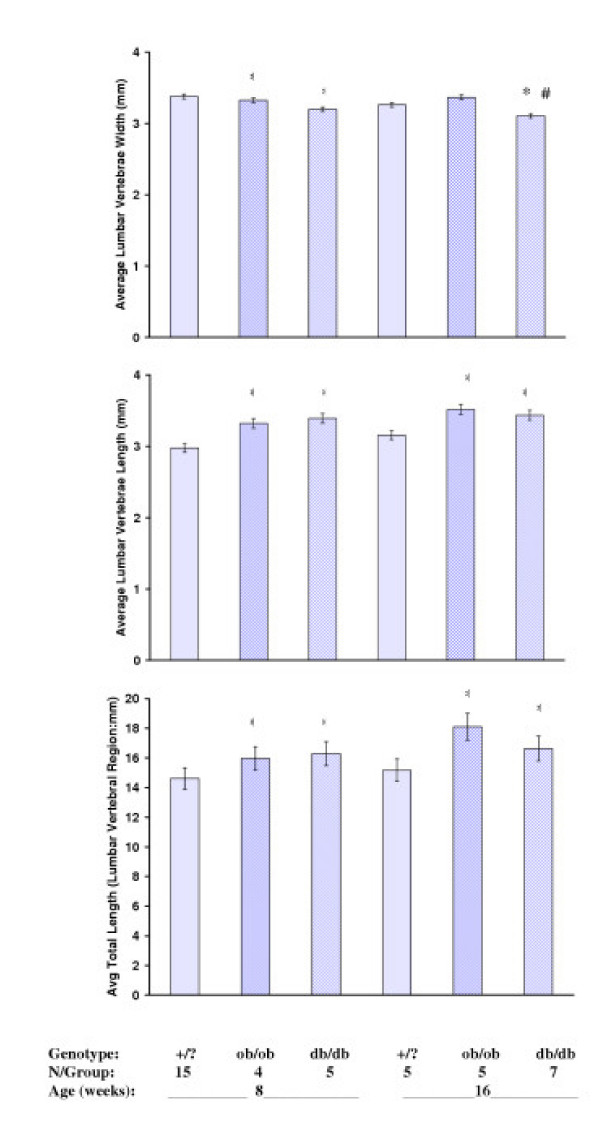
Representation of average lumber vertebral column (VC) lengths, as well as individual lumber vertebrae (LV) length and width indices, are denoted for control (+/?), obese (ob/ob) and diabetes (db/db) mutant genotypes as groups means (± SEM) at 8 and 16 weeks of age. Significant (P ≤ 0.05) intergroup differences (i.e., control v.s. genotype mutant type) at each designed age are denoted by asterisks (*). Age-dependent (i.e., 8 v.s. 16 week values for the same genotype) intragroup differences are denoted by #.